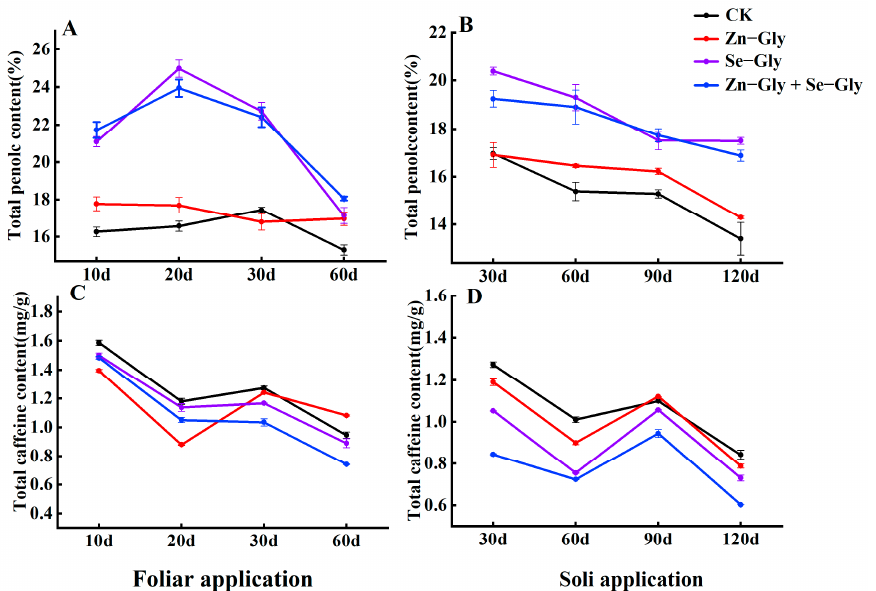
Figure 6. The content of tea polyphenols and caffeine in tea leaves under different treatments. ( A , C ) Content of tea polyphenols and caffeine in tea leaves following foliar fertilizer application; ( B , D ) Content of tea polyphenols and caffeine in tea leaves following fertilizer soil application. The abscissa shows the days of treatment. Different colors represent different treatments, as follows: black, CK; red, Zn − Gly; purple, Se − Gly; blue, Zn − Gly + Se − Gly.